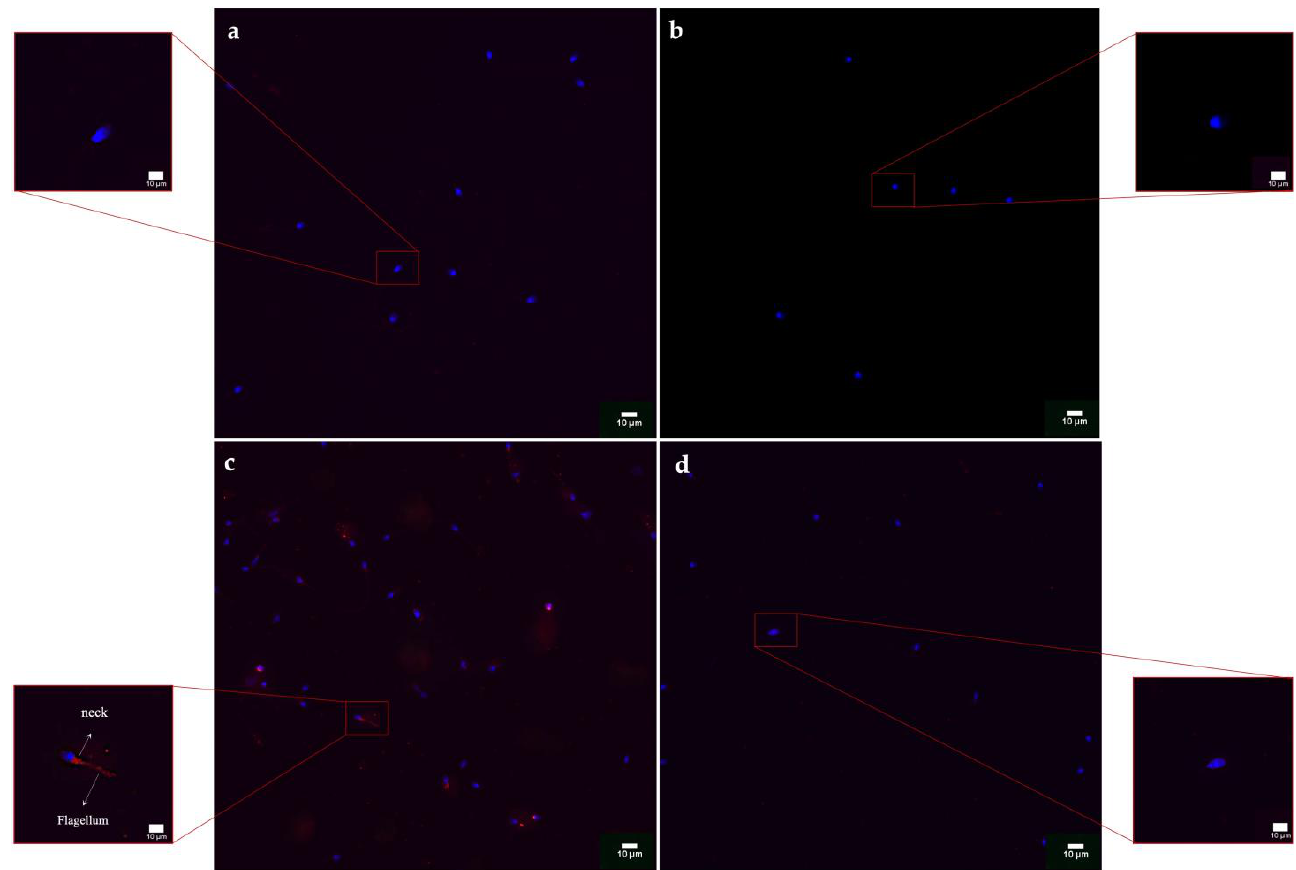
Figure 8. Results of immunohistochemistry protocol for the identification of HSP70 after the exposure (30 min) to 50 and 100 nm PS-NPs at increasing concentrations: ( a ) control (CTRL) with a magnification of a spermatozoon without red spots; ( b ) sample exposed to 100 nm PS-NPs with a magnification of a spermatozoon without red spots; ( c ) sample exposed to 50 nm PS-NPs with a magnification of a spermatozoon with red fluorescence diffused on flagellum; ( d ) negative control with a magnification of a spermatozoon without red spots.